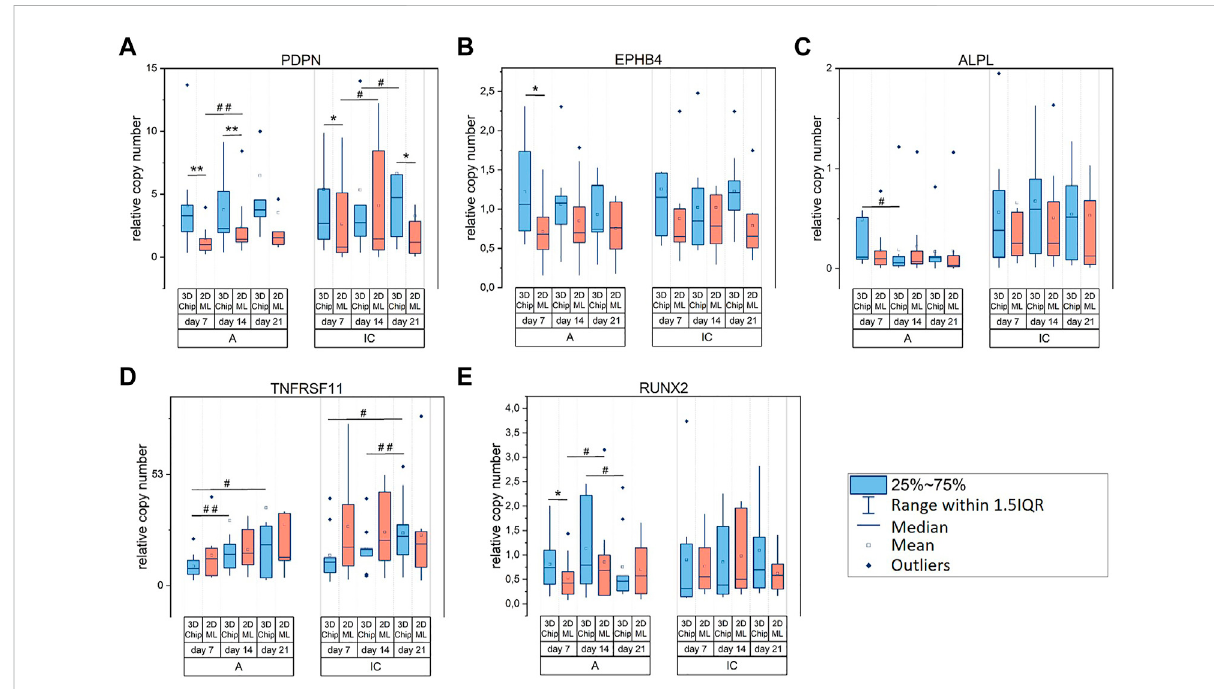
FIGURE 5 (A – E) Relative gene expression of biomarkers in osteoblasts modulated by cell culture con fi guration (2D versus 3D) and/or culture time. Color code of the comparison groups: 3D-microchip in blue and 2D ML in red. Osteoblasts derived from alveolar bone (hOB-A) and iliac crest (hOB-IC) of thesamedonorwereculturedin3D-microchipand2DMLcultureunderosteogenic conditions. Thecopynumbersoftarget genesatdays 7,14 and 21 were normalized to copy numbers of the reference gene HPRT1 (hypoxanthine phosphoribosyl-transferase 1). * p < 0.05, ** p < 0.01 for comparison of 3D-microchipwith 2D ML culture; # p < 0.05, ## p < 0.01 for comparison of culture time; Wilcoxon signed-rank test, n = 9 donors. PDPN(podoplanin),EPHB4(ephrinreceptorB4),ALPL(alkalinephosphatase,liver/bone/kidney),TNFRSF11B(TNFreceptorsuperfamilymember11b) and RUNX2 (runt related transcription factor